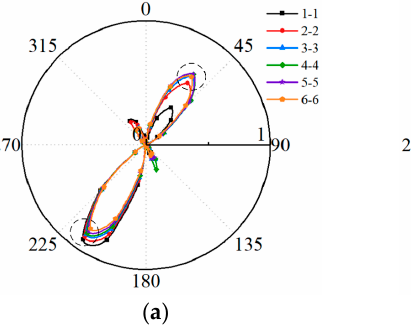
Figure 9. Tensile stress at each section (MPa): ( a ) stress envelopes at incident angle of 0°, ( b ) stress envelopes at incident angle of 30°, and ( c ) curves of max tensile stress values.